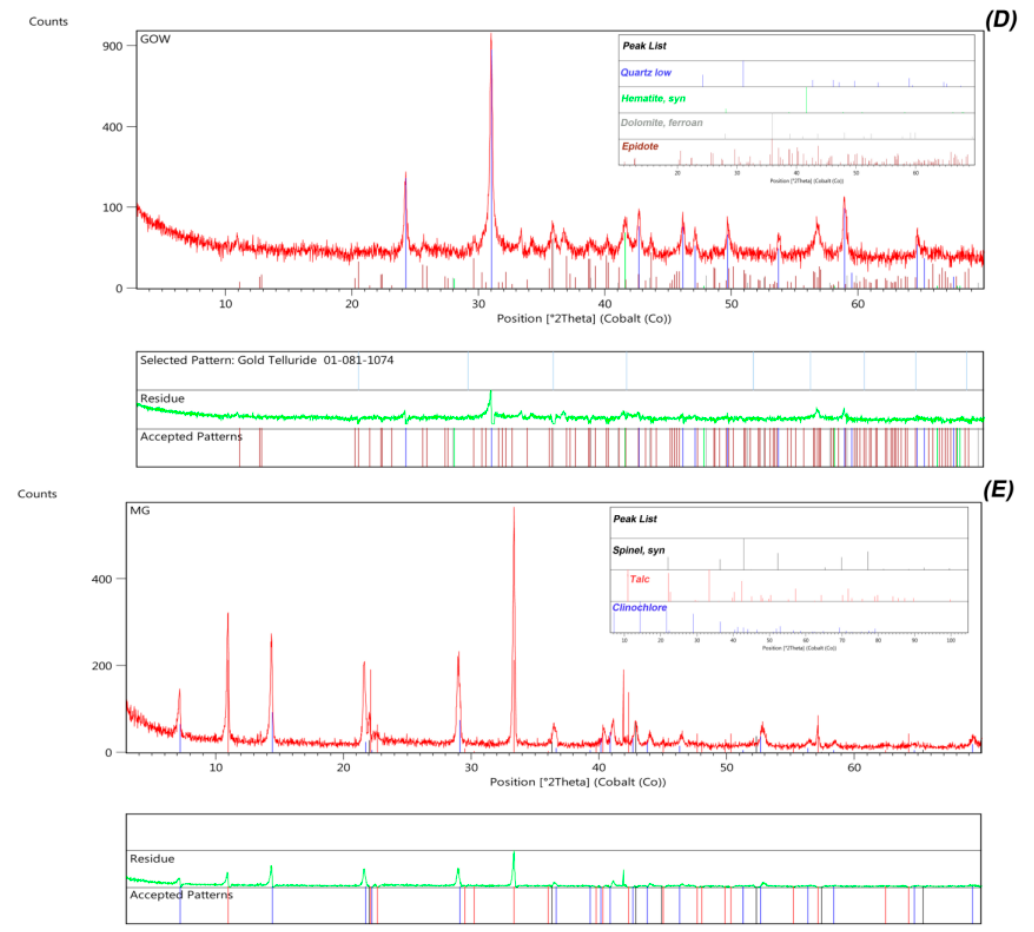
Figure 14. Representative XRD analysis of samples collected from listvenites ( A–C ) and altered Glasgow volcanics (reddish to greenish alterations) at Mt Gow, Bowers Mountains ( D–E ).